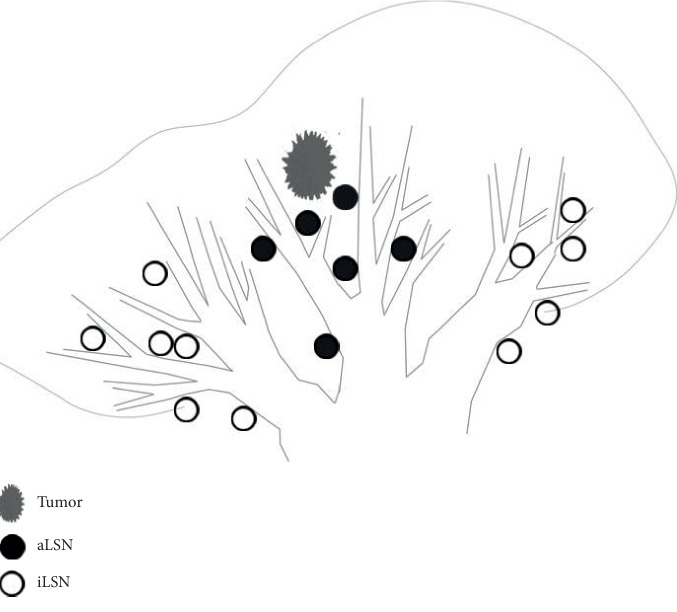
The relationship between the tumor, aLSNs, and iLSNs.